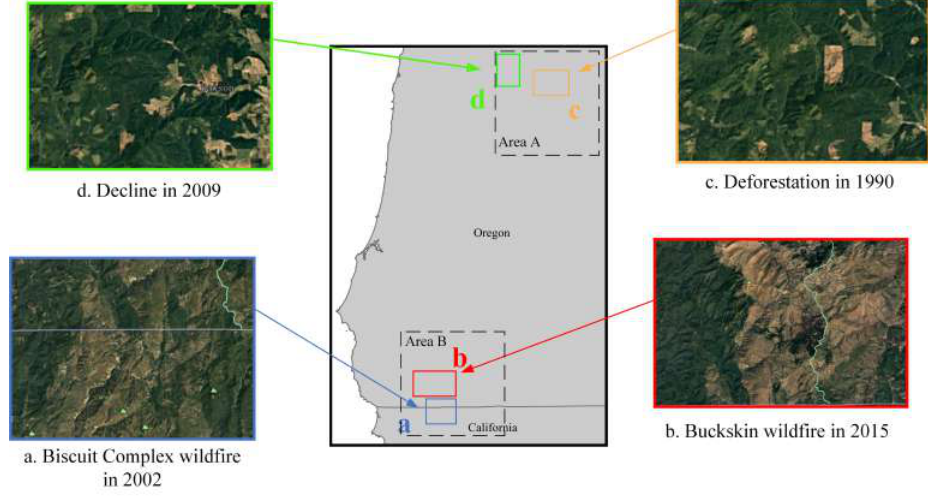
Figure 7. Finer-scale illustration of forest disturbance events with specific